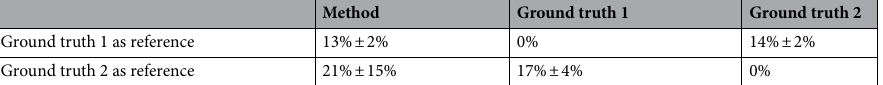
Table 2. Comparison between the total area of the leakage regions obtained from the method and from the ground truths. Each row corresponds to a ground truth used as reference, while each column indicates the agreement between the respective area obtained and the reference